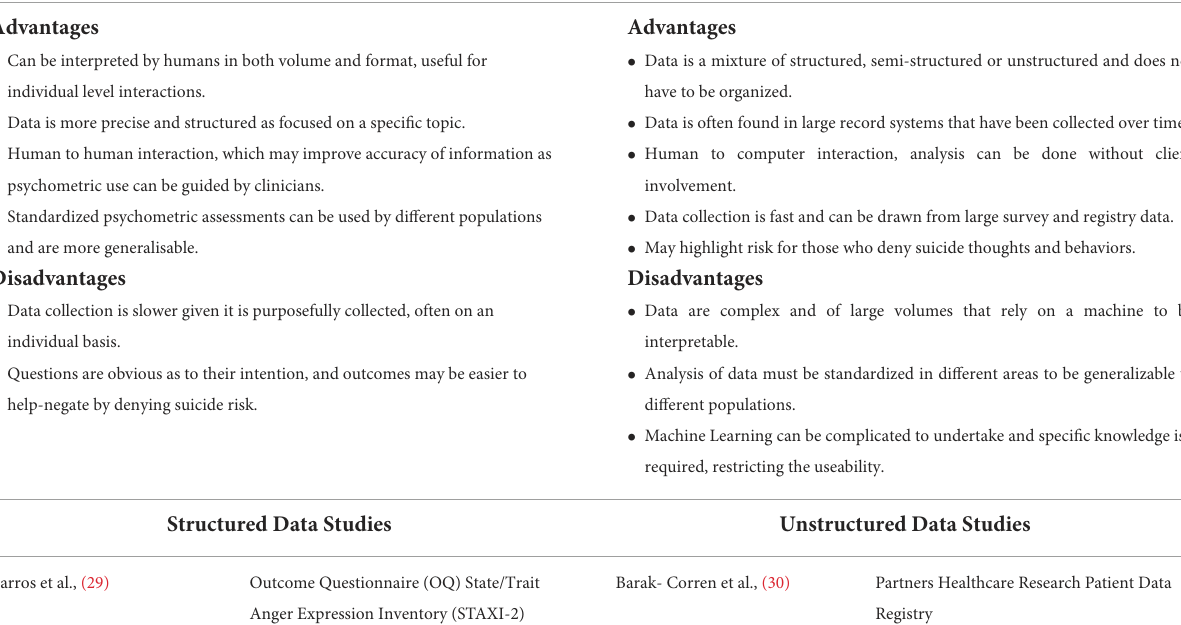
TABLE 1 Critical analysis and data sources for structured and unstructured data